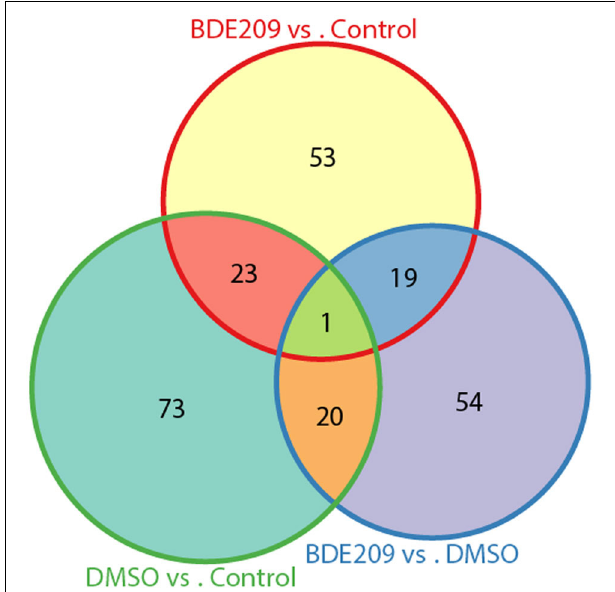
FIGURE 3 | Only small portion of genes are common among the three lists of differentially expressed genes from pairwise comparisons of the three samples. The three lists of genes have only one gene in common. There are only about 20 common genes ( ∼ 25%) shared by each two of the gene sets,